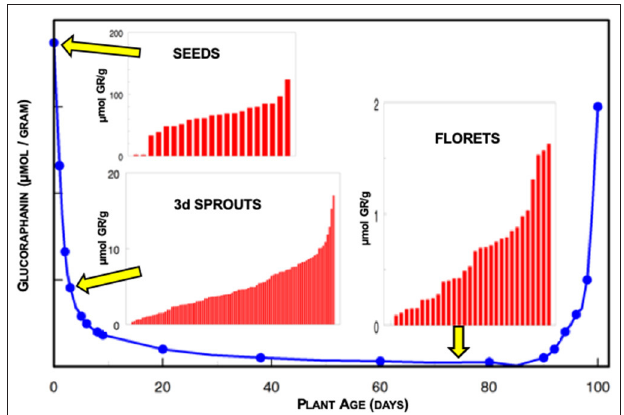
FIGURE 1 | Glucoraphanin (GR) content of broccoli over the life course of the plant expressed on the basis of fresh weight. Inserts indicate the heterogeneity of glucoraphanin content in different cultivars of seeds (2–124 µ mol GR/g), 3-day old sprouts (0.3–17 µ mol GR/g), and market stage florets ( < 0.1–1.6 µ mol GR/g) obtained commercially and measured in the laboratory of JWF. Note the differing scales for each of the insert